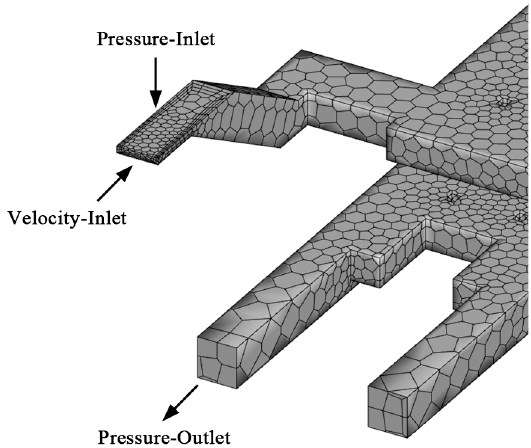
Figure 7. Schematic diagram of the evacuation passages.